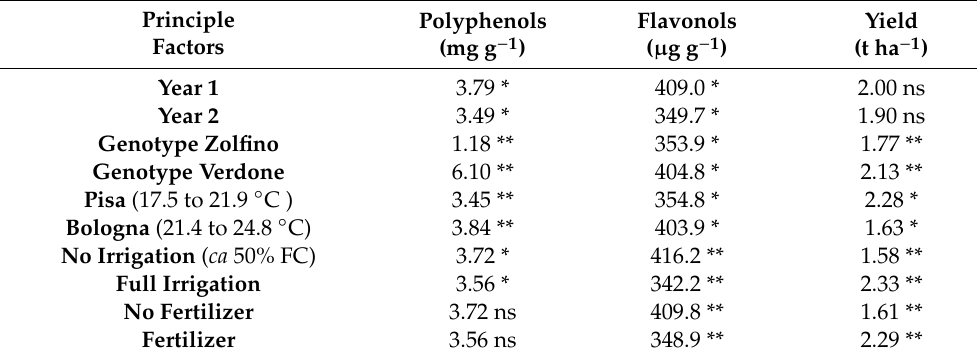
Table 1. Principle factor e ff ects (year, genotype, location, irrigation, and fertilizer treatment) on yield, and polyphenol and flavonol contents. * p significant at p < 0.05, ** p significant at p < 0.01, and ns = not significant ( n = 48). FC = field